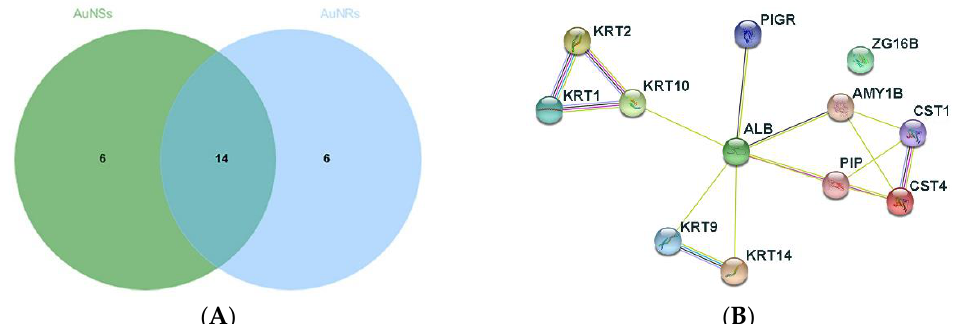
Figure 7. ( A ) The 20 most abundant proteins on the surface of AuNSs and AuNRs; ( B ) correspond- ing PPI network. PPI